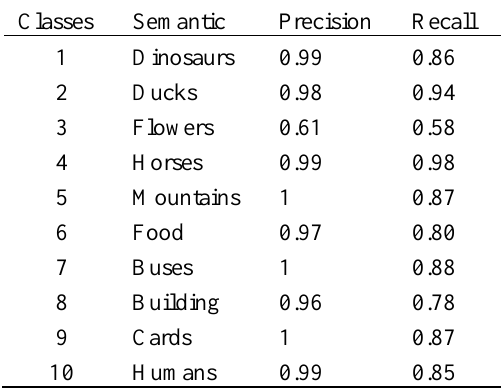
4.1.1.3 Graph representation: The y-axis represents the retrieval percentage while x-axis represents the number of classes.